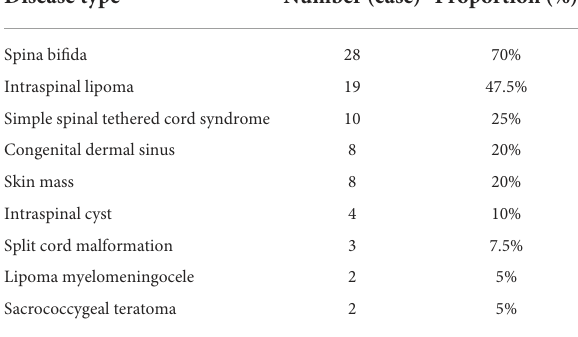
TABLE 1 The number and proportion of different types of spinal cord neural tube defects diagnosed by magnetic resonance imaging after